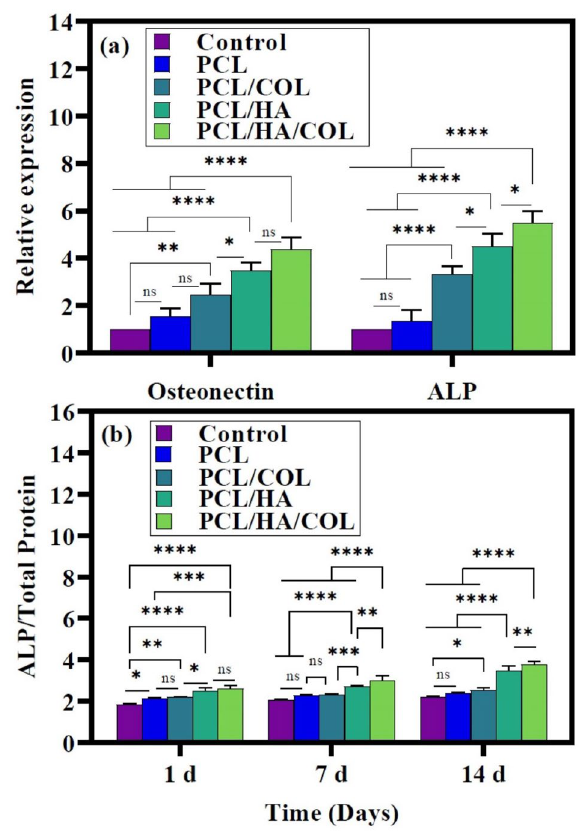
Figure 6. ( a ) mRNA Expression of osteogenic related genes on scaffolds, Osteonectin (first column) and ALP (second column) after 21 days (n = 3, *p ≤ 0.05 vs. Control group). ( b ) ALP activity of hADSCs cells seeded on scaffolds in osteogenic